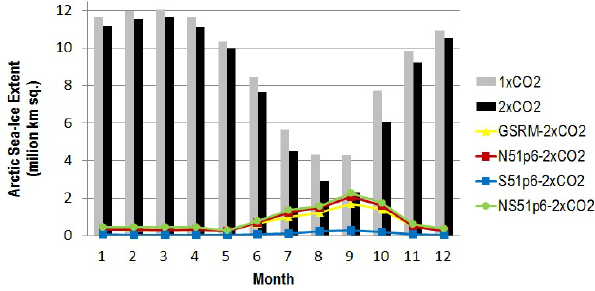
Fig. 5. Monthly variation in Arctic sea ice extent (in millions of km 2 ) for 1 × CO 2 and 2 × CO 2 and the calculated increments in Arctic sea ice that would result from a 1.8% reduction in global solar radiation or from 6% reductions in solar radiation from 51 ◦ latitude to the pole in the Northern, Southern, or both Hemispheres, showing that reducing solar radiation by these amounts would, as intended, have the effect of essentially restoring Arctic sea ice cover.